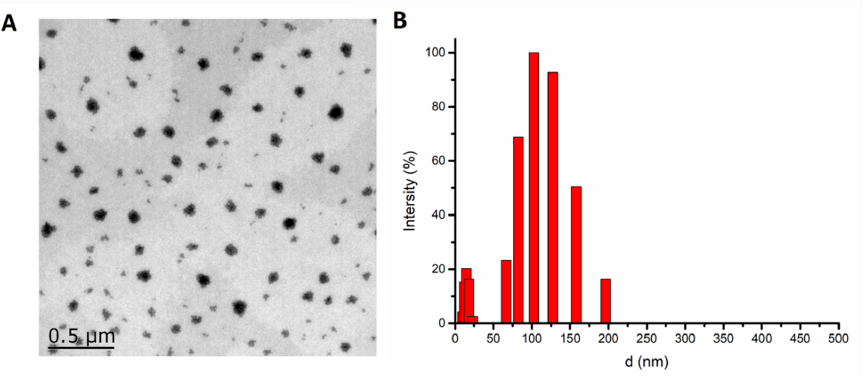
Figure 1. Transmission electron microscope ( A ) and the dynamic light scattering ( B ) results of 6-shogaol loaded micelles (SMs). [10/1, the mass of methoxypolyethylene glycol (MW = 2000)-linoleate acid conjugate (mPEG 2k